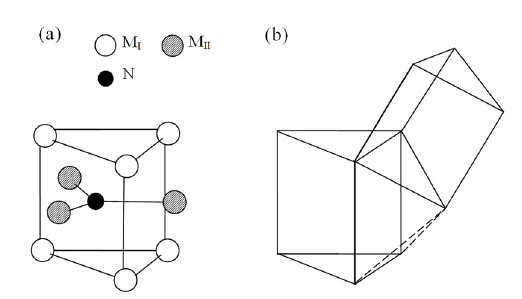
Figure 5. Gaskell's stereochemical model: (a) Regular trigonal prismatic coordination; (b) Edge-sharing of polyhedra.